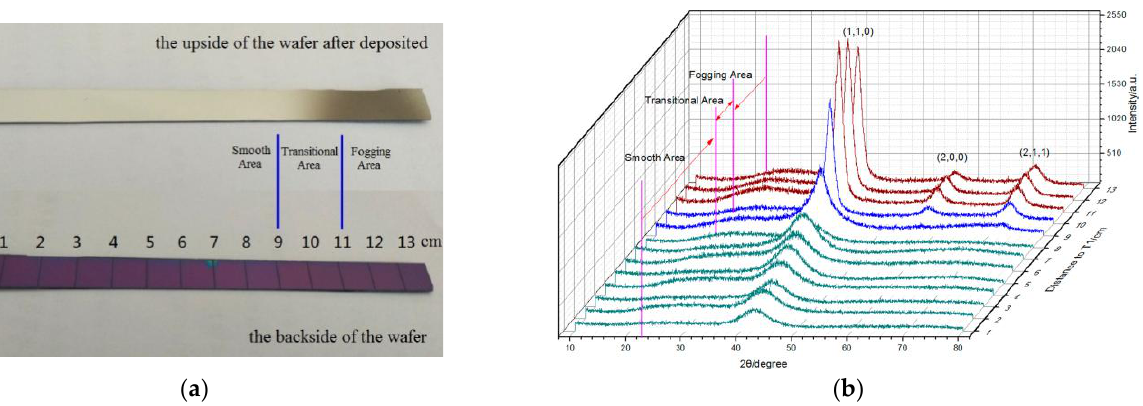
Figure 6. Microstructure evolution of CCAs fabricated by high-throughput technique: ( a ) The gradient (CrFeV)-(TaW) low-activation film after co-sputtering; ( b ) The phase evolution of (CrFeV)- (TaW) low-activation CCA films prepared by co sputtering, reprinted with permission from Ref. [61].